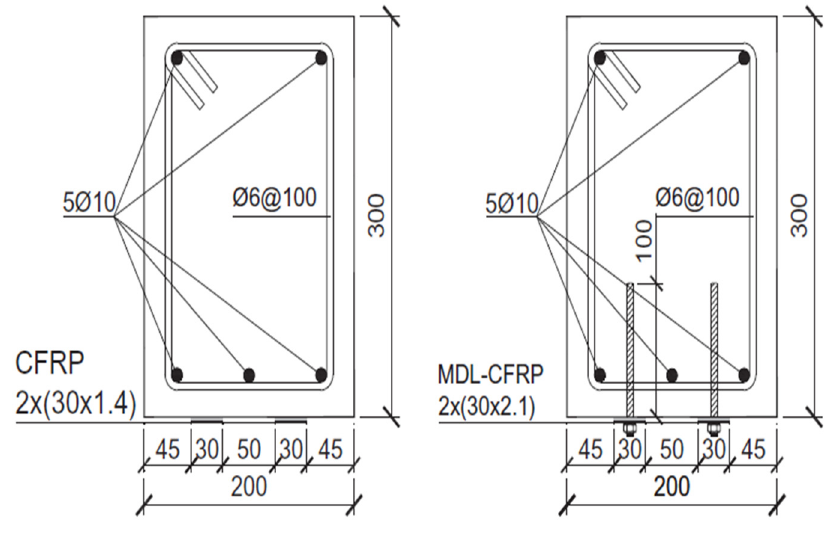
Figure 9. Cross-section of EBR and MF-EBR [62].